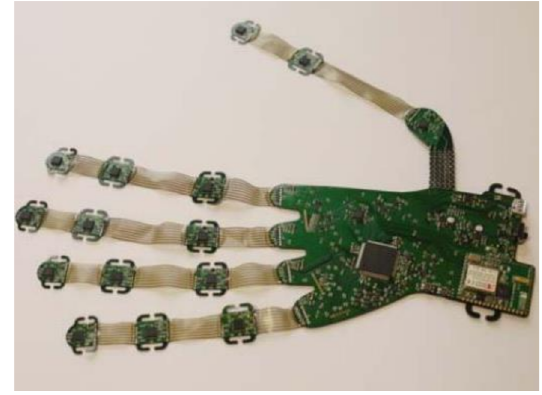
Figure 25. IMU Smart Glove rev 2